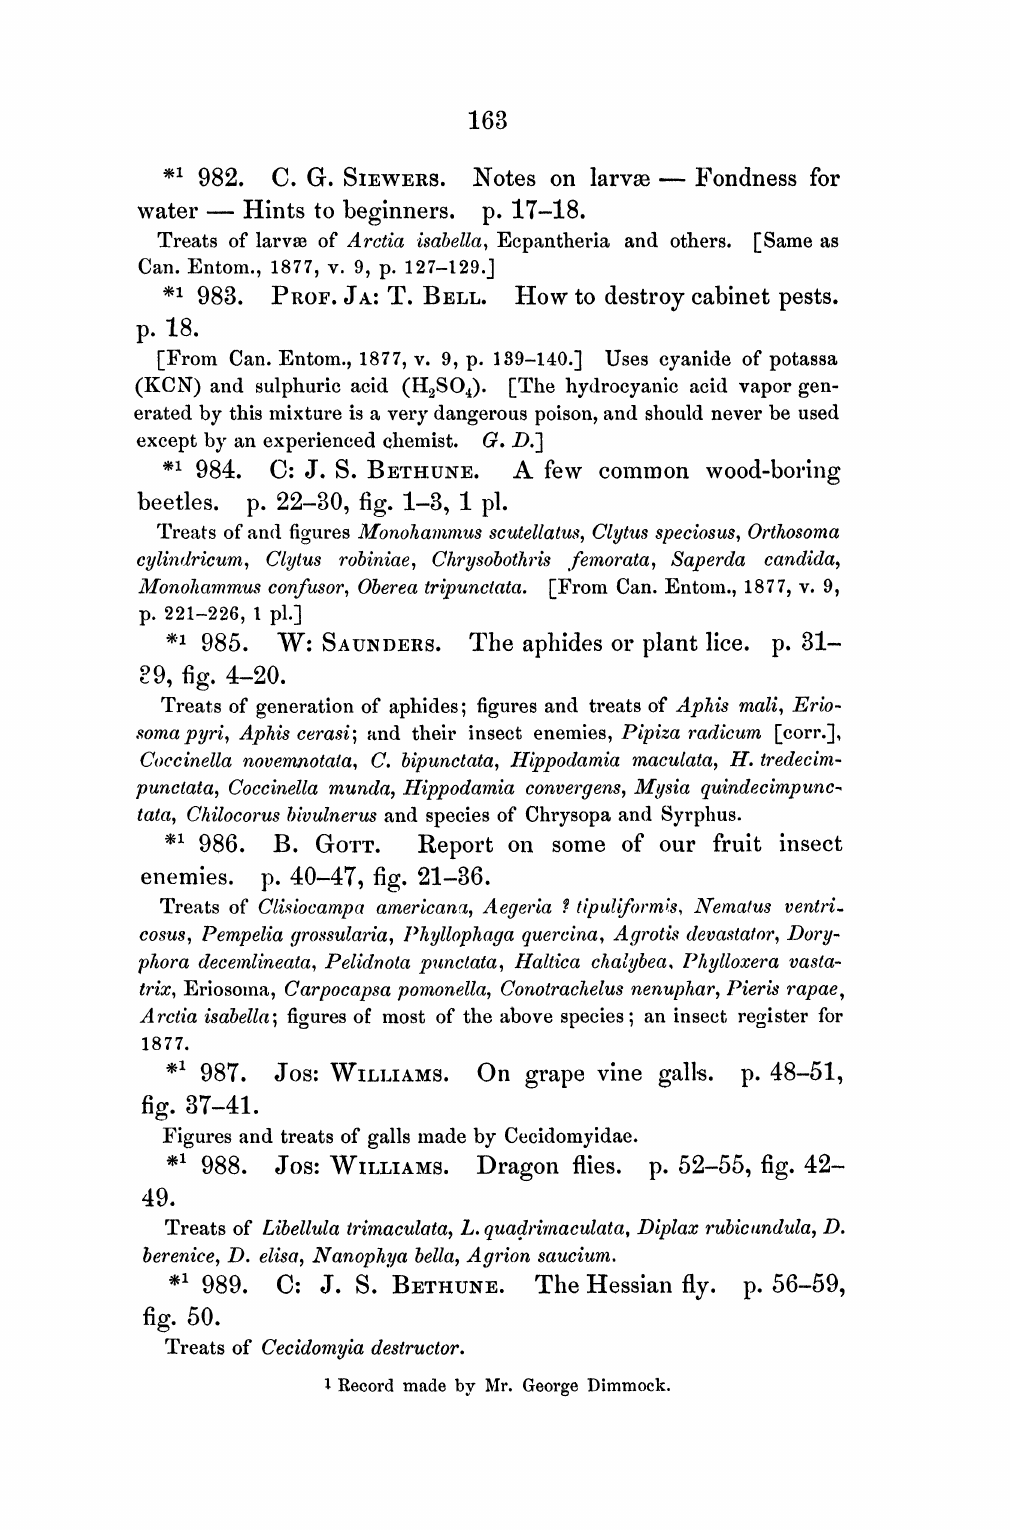
Treats of Cecidomyia